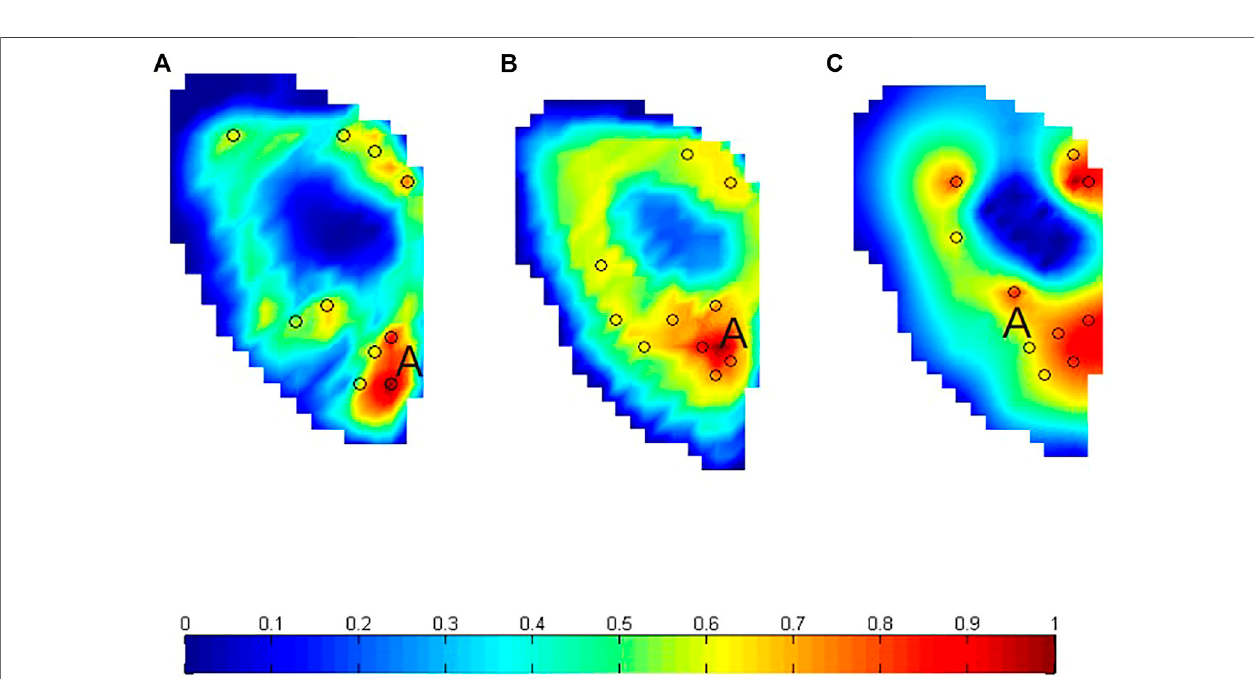
FIGURE 6 | Production potential maps produced by (A) analysis method, (B) fuzzy system method, and (C) numerical simulation method.